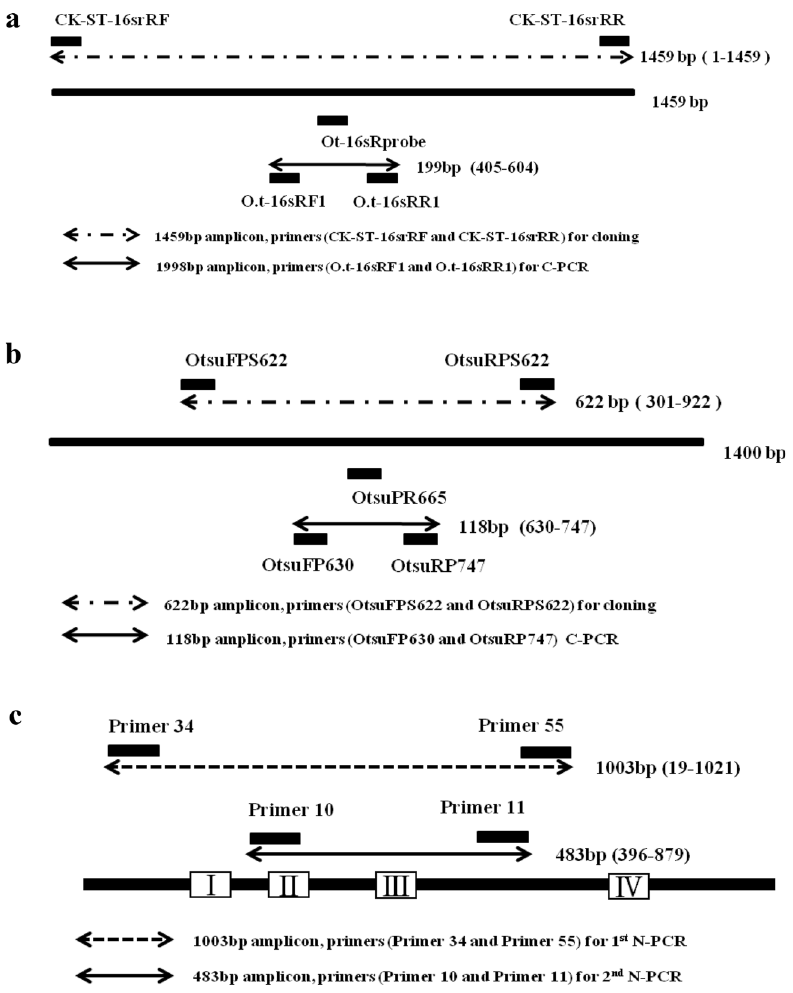
Figure 1. Diagram indicating the primer positions in Orientia tsutsugamushi . ( a ) 16S rRNA gene. ( b ) 47-kDa protein gene. ( c ) 56-kDa protein